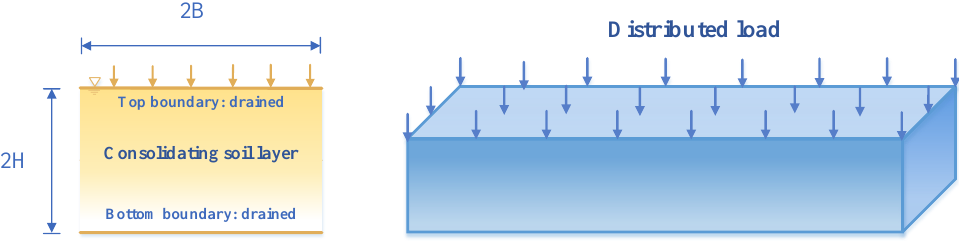
Figure 5. Schematic diagram of two-dimensional soil consolidation for drainage at the top and bottom